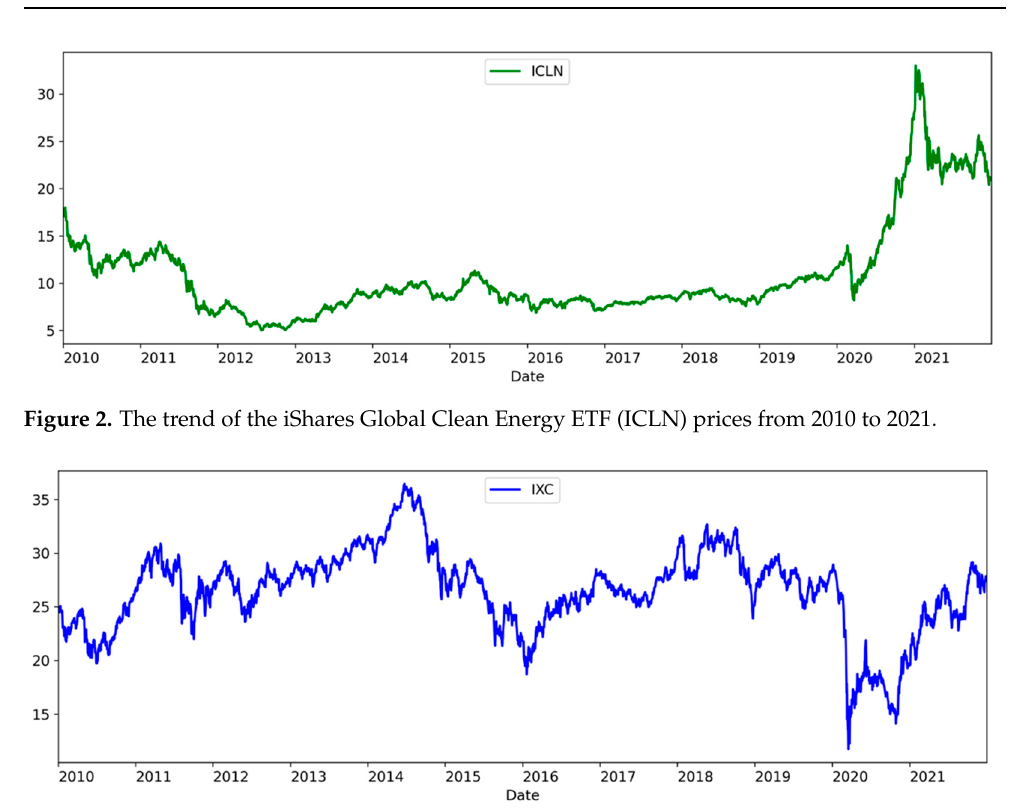
Figure 3. The trend of the iShares Global Energy ETF (IXC) prices from 2010 to 2021.